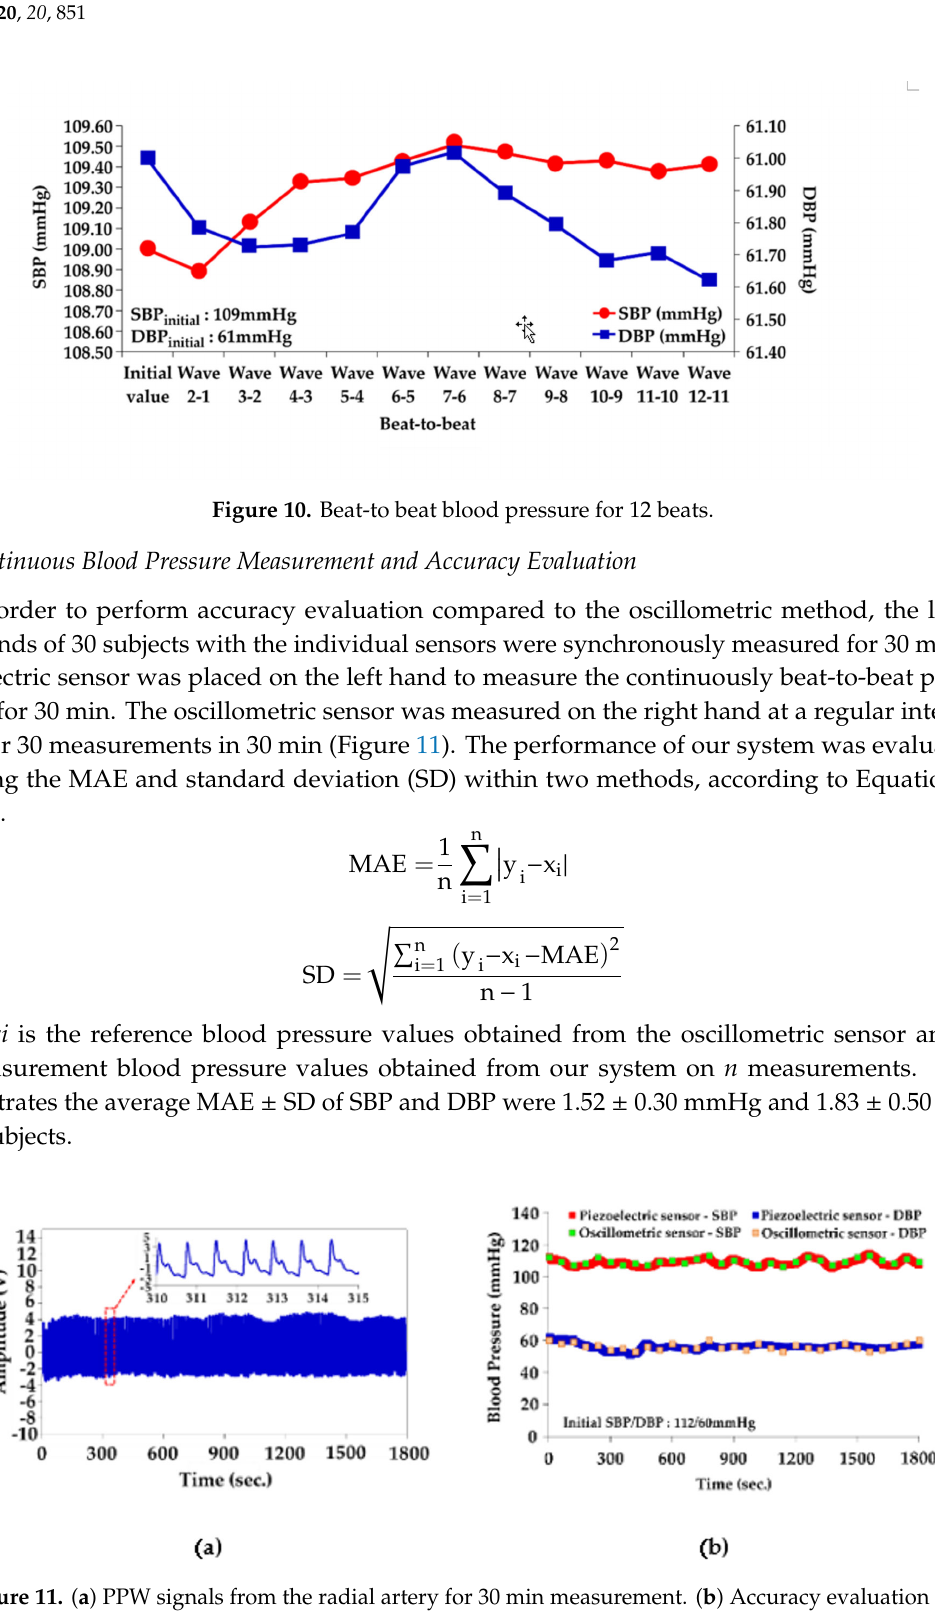
Figure 11. ( a ) PPW signals from the radial artery for 30 min measurement. ( b ) Accuracy evaluation for a piezoelectric-base system for 30 min measurement, compared to an oscillometric sensor (Subject